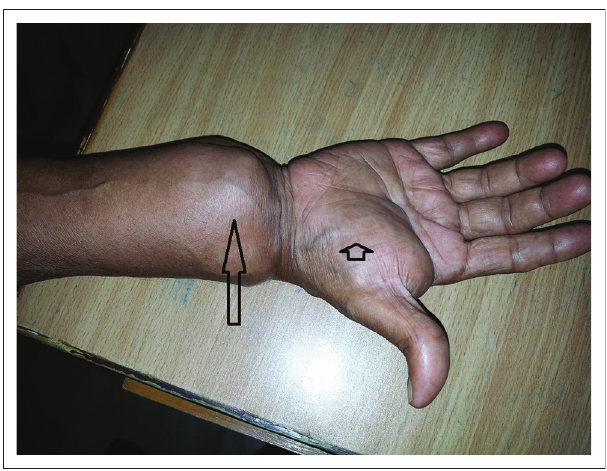
FIGURE 1: Photograph of the patient’s wrist demonstrates bilobed swelling both proximal (larger arrow) and distal (smaller arrow) to the proximal wrist